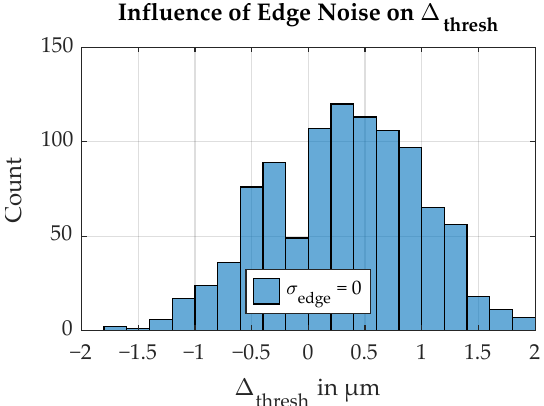
Figure 11. Histogram of simulated deviations in threshold position, edge noise Variant A, 1000 simu- lation repetitions. The resulting uncertainty is σ ∆ , thresh = 18.9µm.